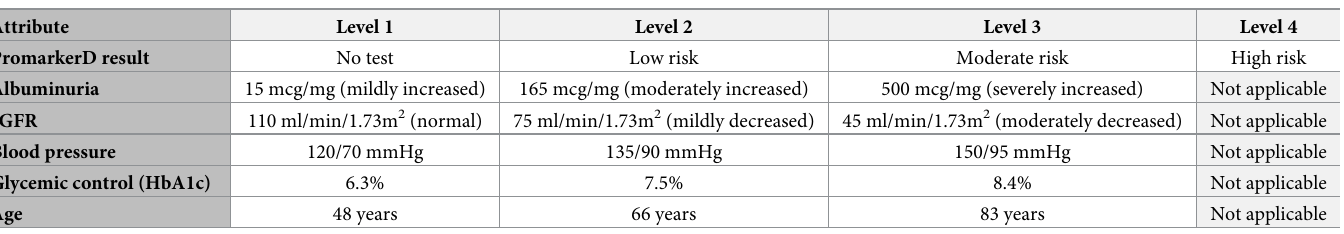
Table 1. Detailed attributes and